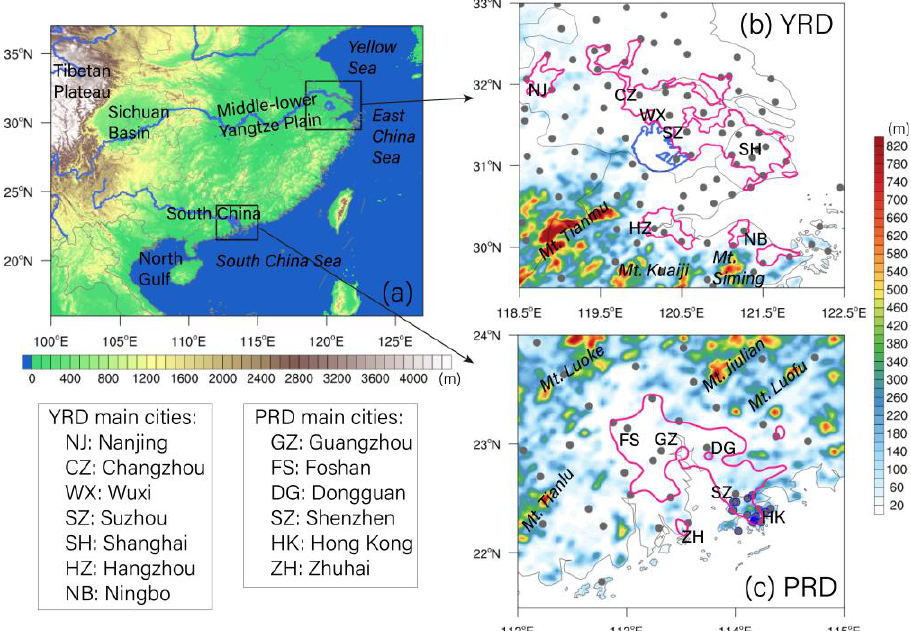
Figure 1. Topography (color shadings) over ( a ) southern China and surrounding areas and the ( b ) YRD and ( c ) PRD regions, respectively. In ( b , c ), gray dots denote the surface weather stations with one blue dot denoting the Hong Kong Observatory (HKO) station; pink lines denote the urban regions; names of major cities are given by abbreviation; major mountains are labeled. Blue lines in ( b ) indicate Lake Taihu. Gray lines indicate the national and provincial boundaries and coastal lines.